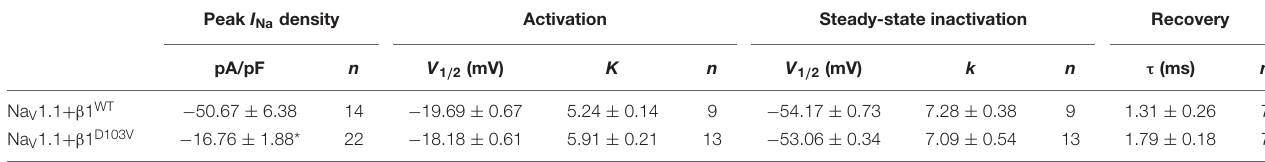
TABLE 6 | Biophysical parameters of Na V 1.1 channels cotransfected with β 1 WT or β 1 D103V . Peak I Na density Activation Steady-state inactivation